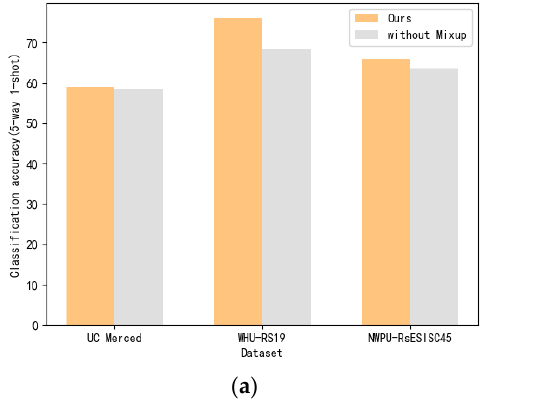
Figure 7. Ablation experiment of three datasets. ( a ) is the ablation experiment on 5-way 1-shot, and ( b ) is the ablation experiment on 5-way 5-shot.